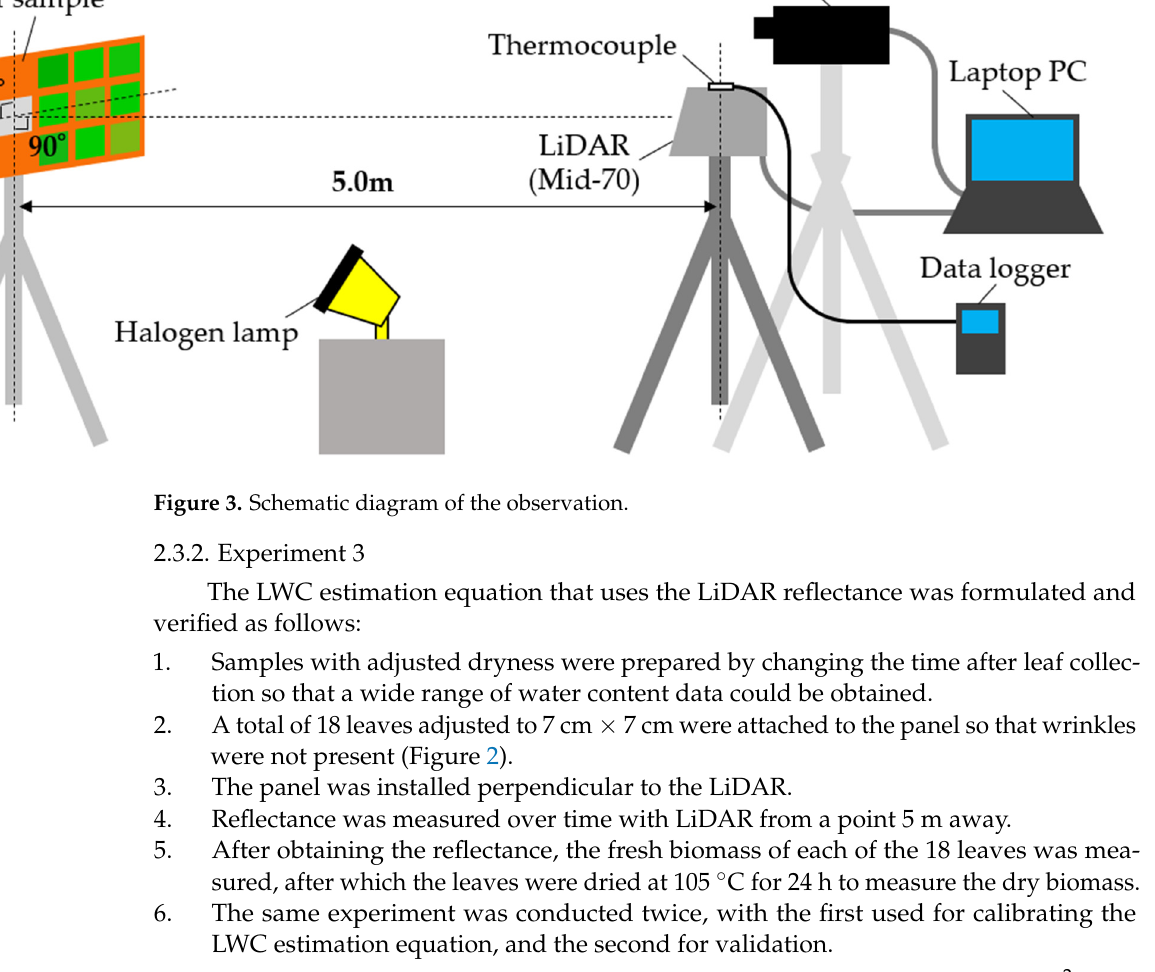
Figure 3. Schematic diagram of the observation.